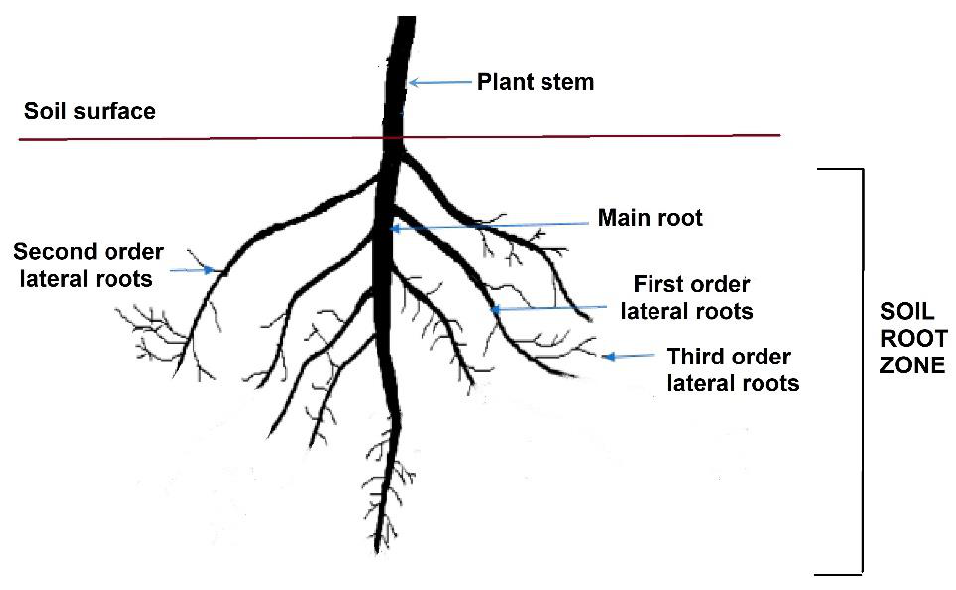
Figure 10. A typical root system architecture.